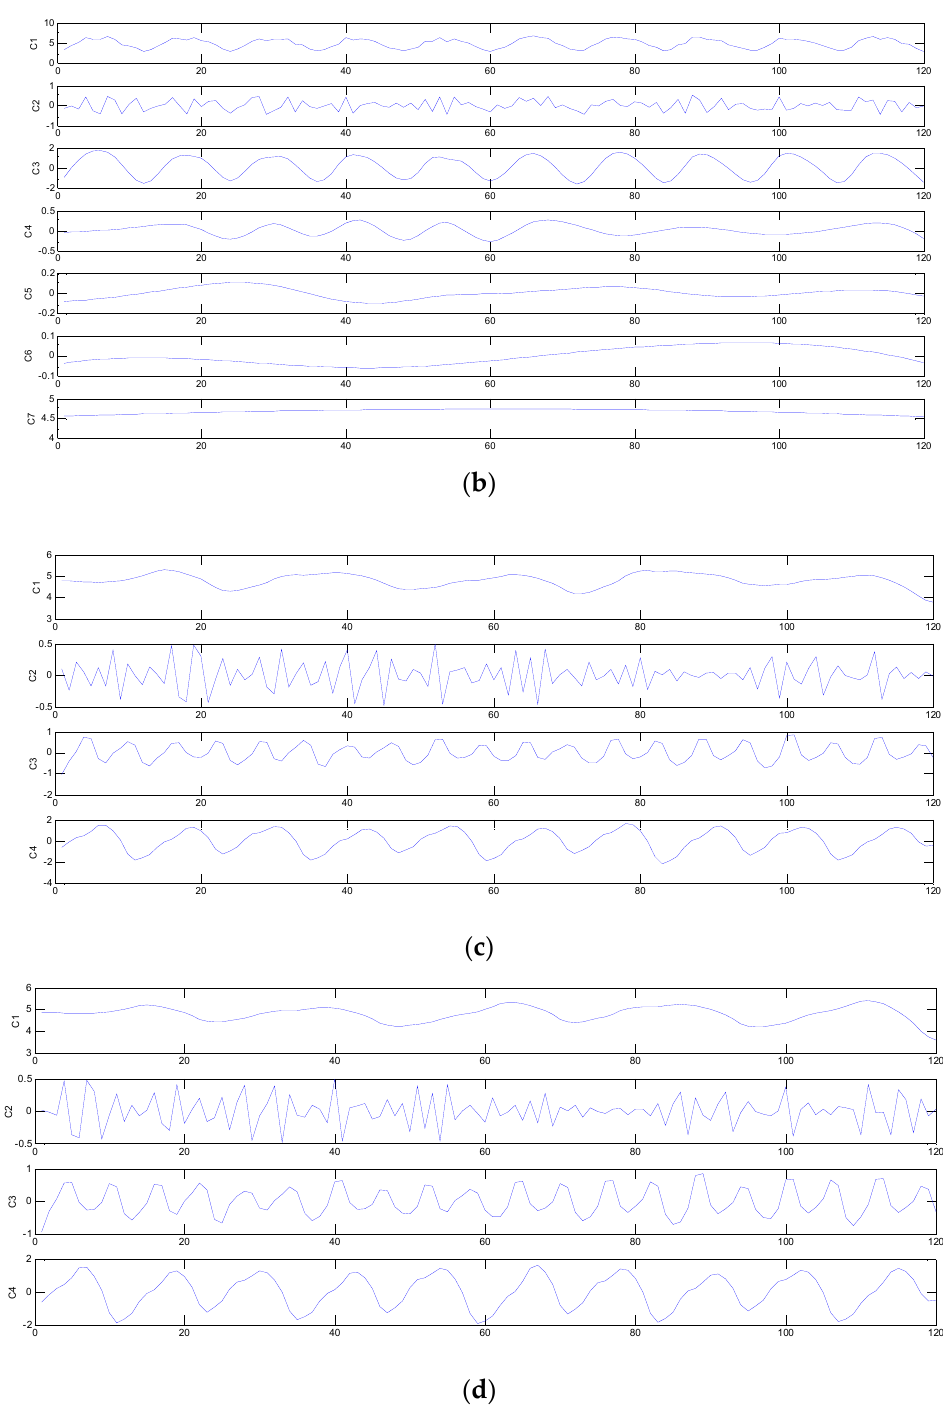
Figure 3. IMFs obtained from EEMD using monthly solar radiation data of ( a ) 1984–1993, ( b ) 1985–1994, sequences with different frequencies obtained from WA using monthly solar radiation data of ( c ) 1984–1993, ( d ) 1985–1994. Figure 4 shows the daily prediction results by different prediction models, as well as the its statistical results with a time step of 10 days and 1 month.